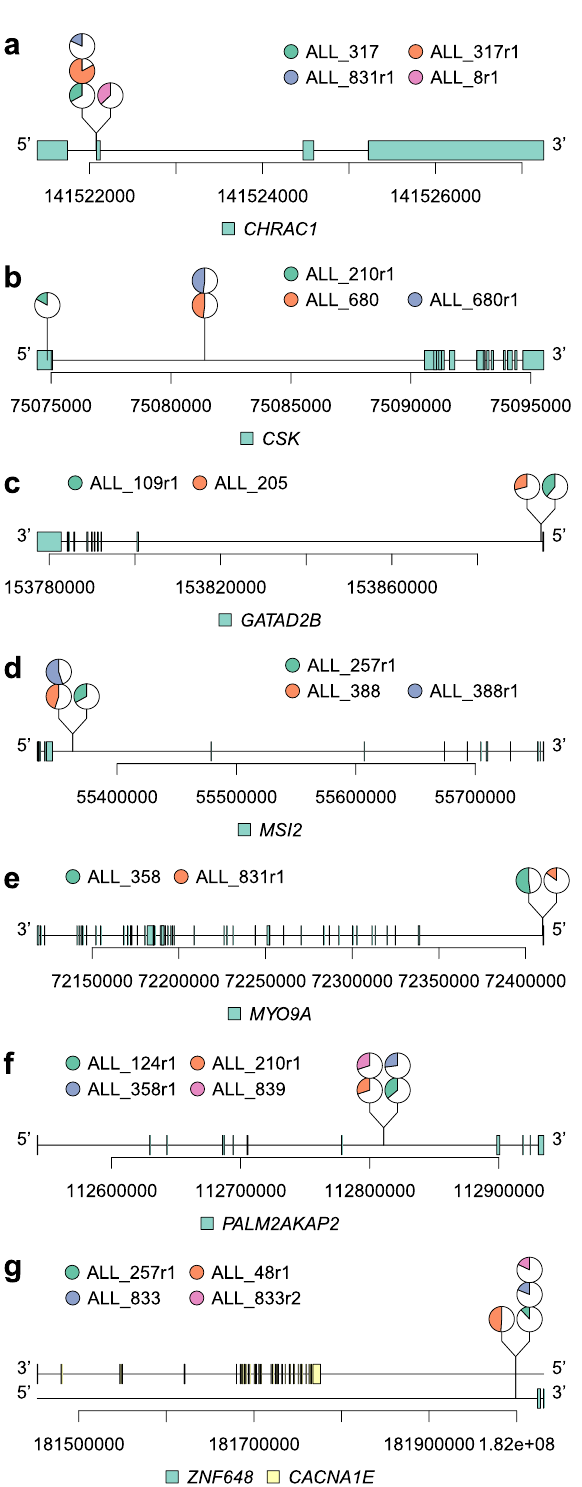
Figure 3. Non-coding single-nucleotide variants (SNVs) in regulatory regions of seven genes in patients with ALL. ( a – g ) Lollipop plots showing pie charts with the mutant allele frequencies and genomic positions of each mutation. Pie charts stacked above each other illustrate that the mutation in each sample is located at the same nucleotide position. The gene names and genome coordinates are shown at the bottom of each panel. Coding exons are indicated as vertical bars and/or turquoise boxes. The samples carrying the mutations, with first and second relapses marked with r1 and r2, respectively, are shown with the same color-code as the pie charts in the top part of each panel. With the exception of the SNVs in the CSK gene ( b ), the somatic SNVs in each gene are located within a small fragment of 5–19